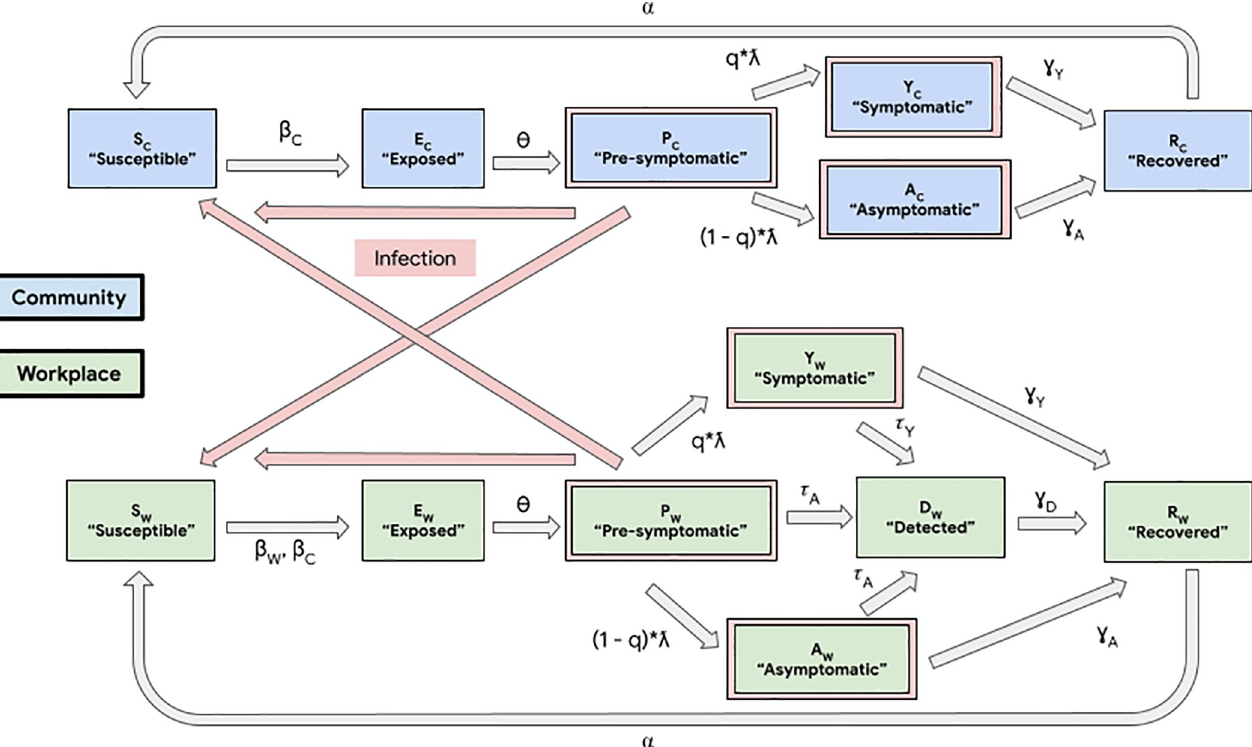
Fig 1. “Community-Workplace” compartmental model of disease spread in the workplace and community. The non-employees (“Community”, shaded blue, denoted with subscript “C”) are modeled using SEPAYR (Susceptible—Exposed—Presymptomatic—Asymptomatic—sYmptomatic—Recovered) compartments. The employees (“Workplace”, shaded green, denoted with subscript “W”) additionally can move through a Detected compartment, resulting in a SEPAYDR (Susceptible—Exposed—Presymptomatic—Asymptomatic—sYmptomatic—Detected—Recovered) model that tracks the stages of COVID-19 infection and detectability by workplace testing. Compartments of individuals that are sources of infections are outlined in pink, and pink arrows denote the paths of potential infections, i.e., disease transmissions. Model transition rate parameters are denoted on compartment-to-compartment transition arrows, and their semantics are detailed in S1